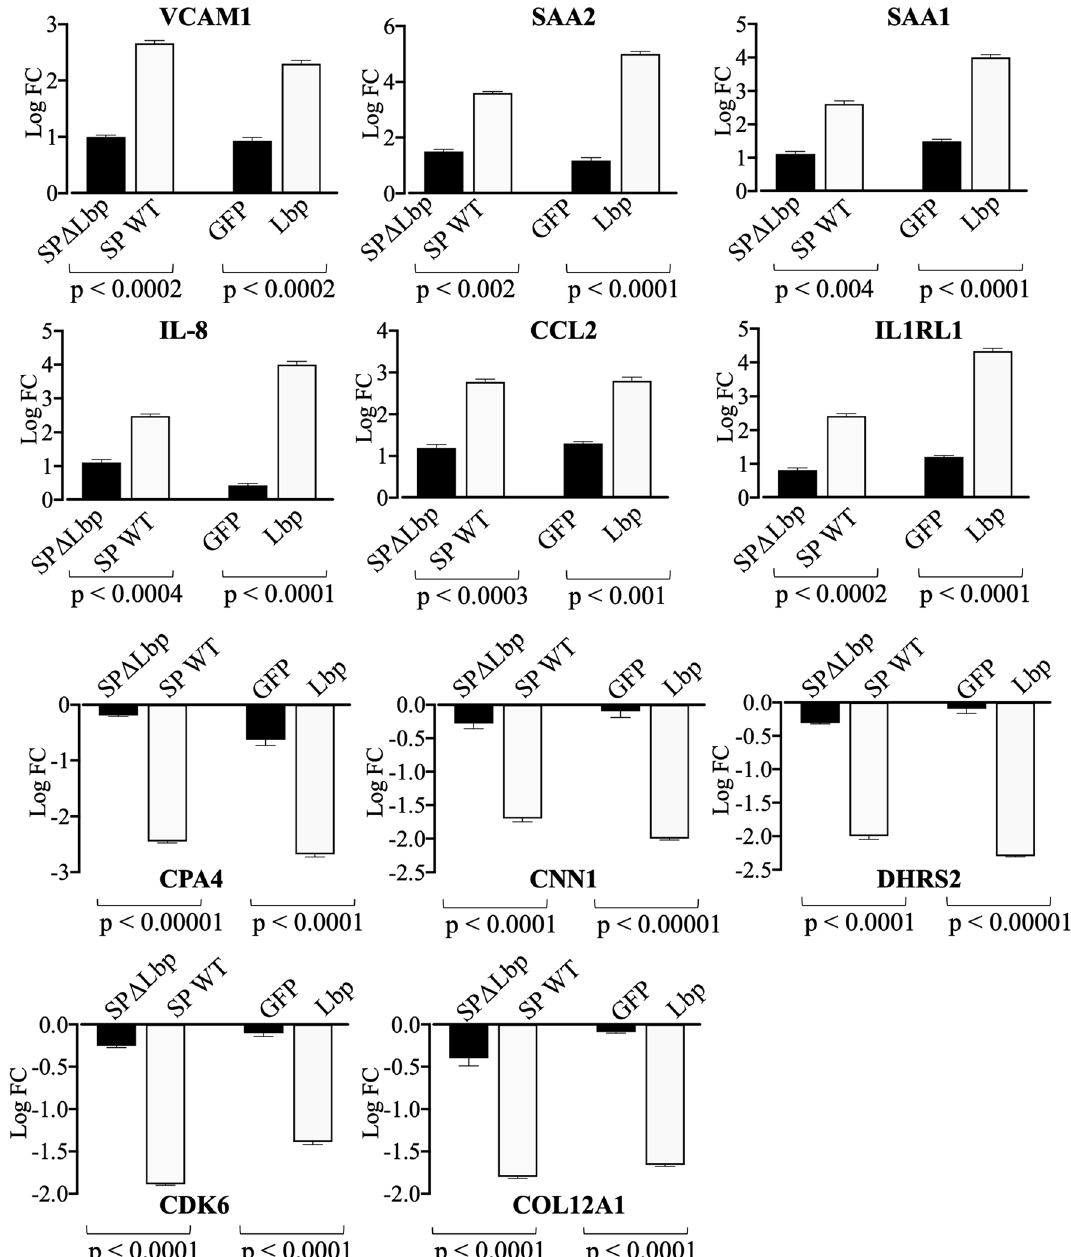
Figure 5. Comparison of expression of selected genes in hBMECs. Comparison was performed between hBMECs induced by S. pneumoniae wild type (SP WT) and S. pneumoniae Δ Lbp (SPΔLbp) using qRT-PCR. Comparison was also performed between hBMECs induced with GFP and Lbp using same set of the genes. Statistically significant difference (p < 0.01, two-tailed p value) was calculated by unpaired t test. Sta t istics was performed with on-line statistics tool of GraphPad https:// www. graph pad. com/ quick calcs/